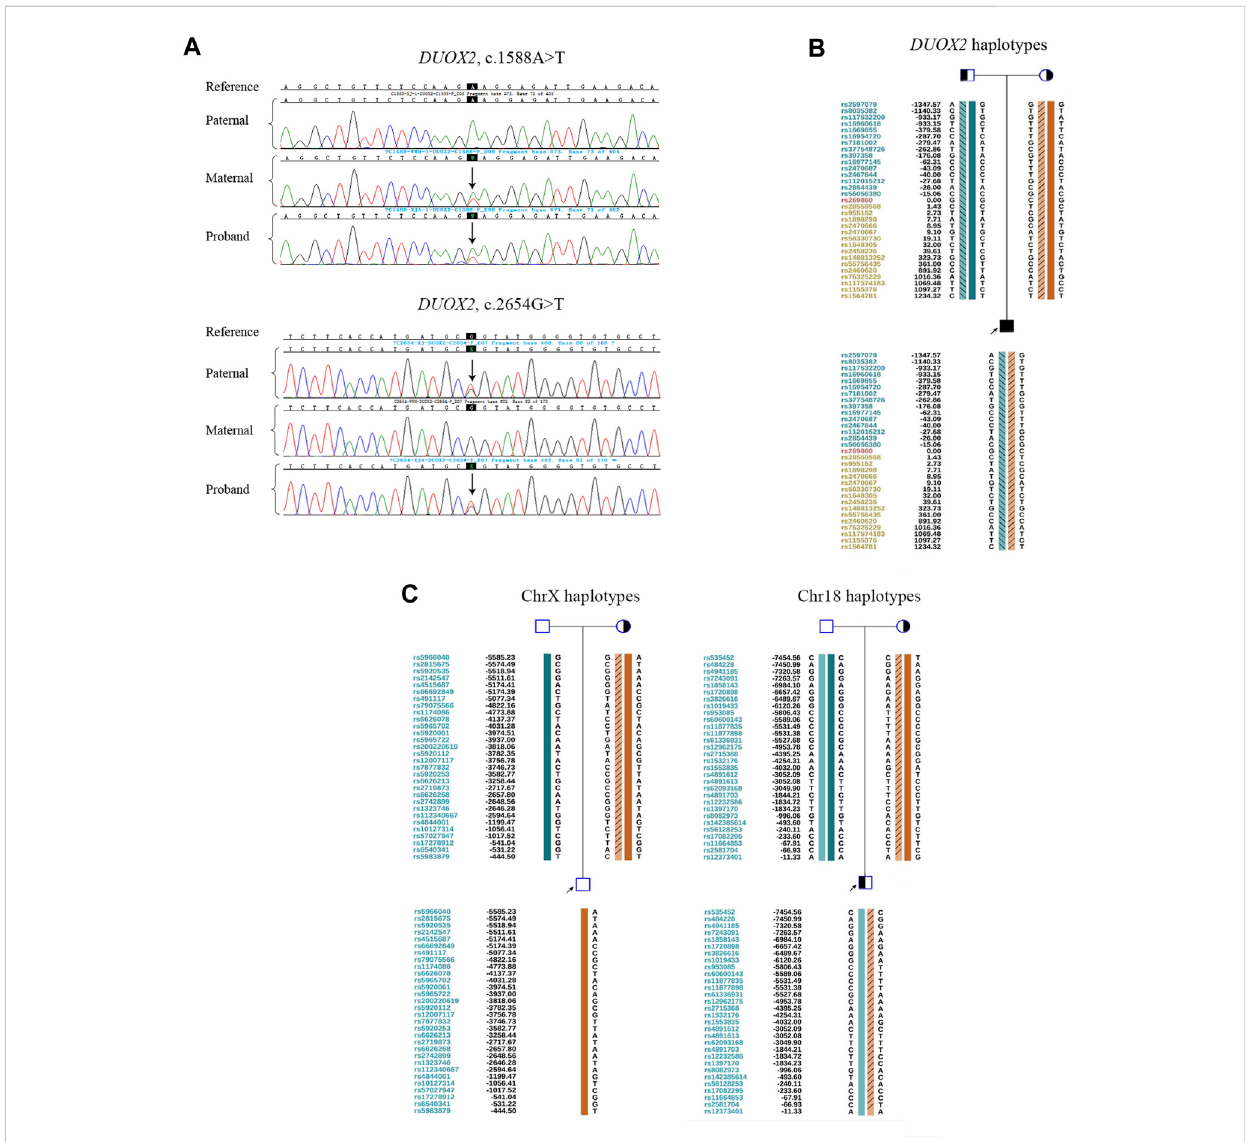
FIGURE 1 Preliminary experiments. (A) Sanger sequencing results for validation of the DUOX2 mutations in c.1588A > T (p.K530X) and c.2654G > T (p.R885L) in family members. The black background indicates the targeted mutation sites. Arrows denote mutations. (B) Pedigree haplotyping analysis based on informative SNPs fl anking DUOX2 . The arrow indicates the proband. Circles and squares indicate females and males, respectively. The fi lled symbol represents the affected patient. Half- fi lled symbols represent DUOX2 mutation carriers. Haplotypes are represented by colorful bars combined or not combined with diagonal lines. The dark green bar indicatesa paternalwild-typehaplotype.The lightgreenbarcombinedwith diagonallines denotes a paternal mutation: DUOX2 , c.2654G > T (p.R885L). The dark orange bar denotes a maternal wild-type haplotype. The light orange bar combined with diagonallinesindicatesamaternalmutation: DUOX2 ,c.1588A > T(p.K530X). (C) Pedigreehaplotypesaroundchromosomalbreakpointregions.Thearrow indicates the proband. Circles and squares indicate females and males, respectively. Half- fi lled symbols represent derivative chromosome carriers. In ChrX, the dark green bar indicates the normal paternal ChrX haplotype. The dark orange bar denotes the normal maternal ChrX haplotype. Light orange bars with diagonal lines represent the derivative ChrX haplotype. In Chr18, the dark and light green bars indicate a pair of paternal normal Chr18 haplotypes in two homologous chromosomes. The dark orange bar represents the normal maternal Chr18 haplotype. The light orange bar combined with diagonal lines denotes the derivative Chr18